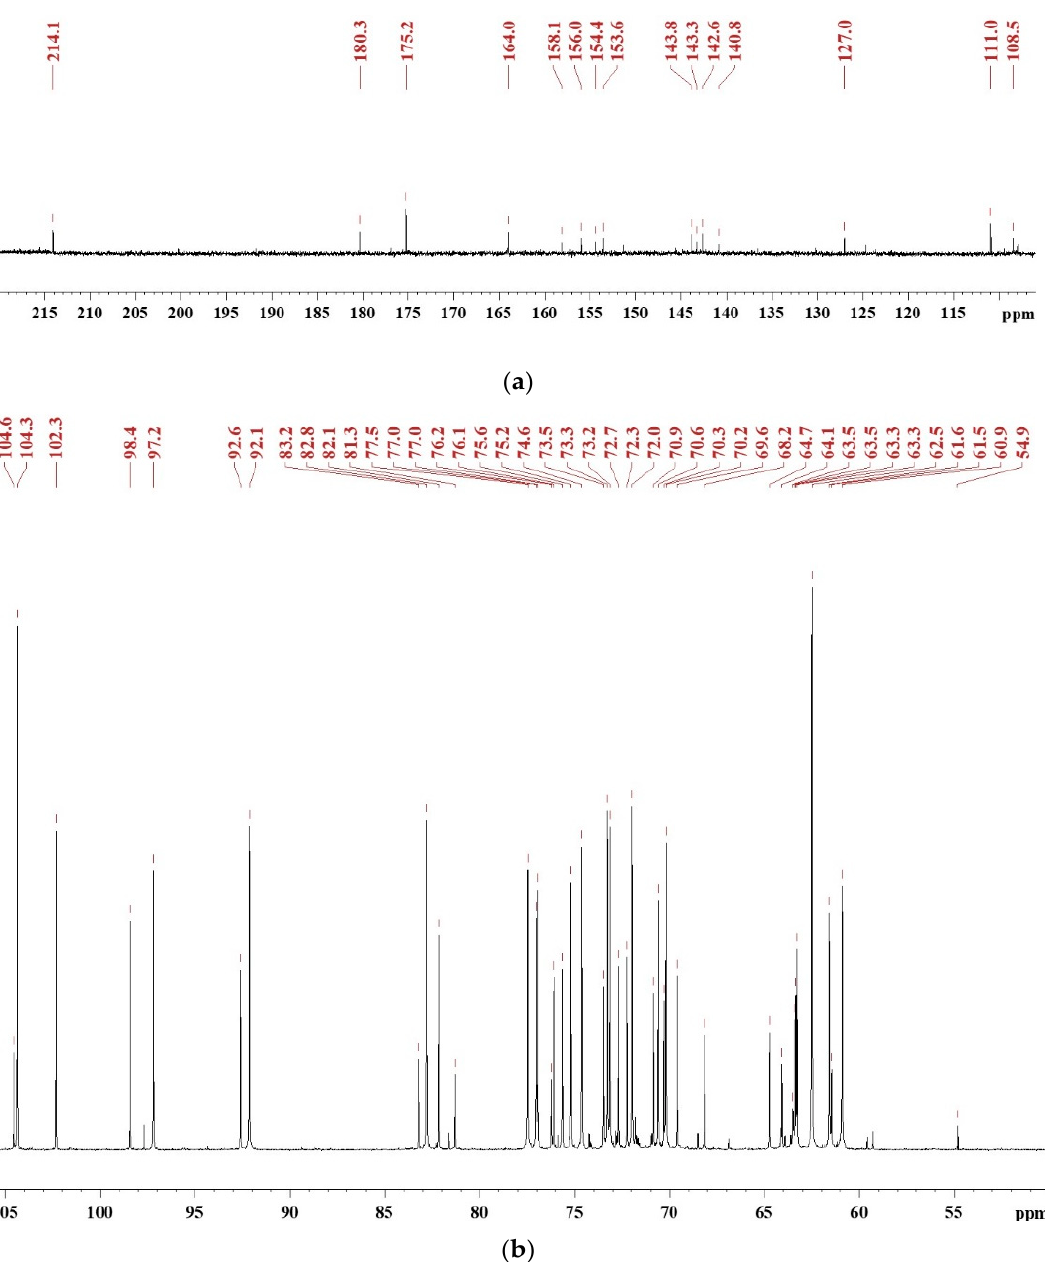
Figure 1. 13 C NMR spectrum of freeze-dried SADP adhesive in DMSO- d 6 : ( a ) chemical shifts in the region of 220–106 ppm and ( b ) the chemical shifts in the region of 106–50 ppm.